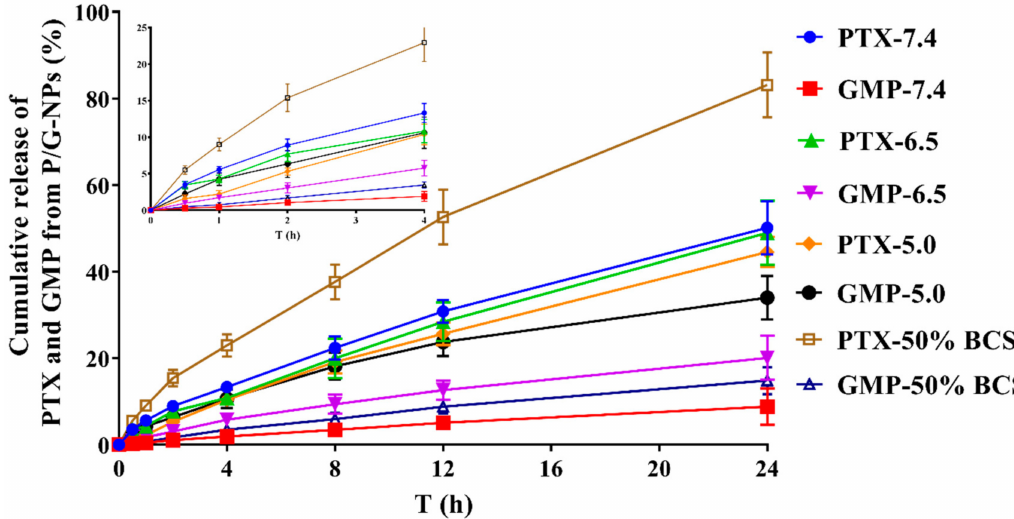
Figure 3. Cumulative release of PTX and GMP from P/G-NPs in different mediums ( n =